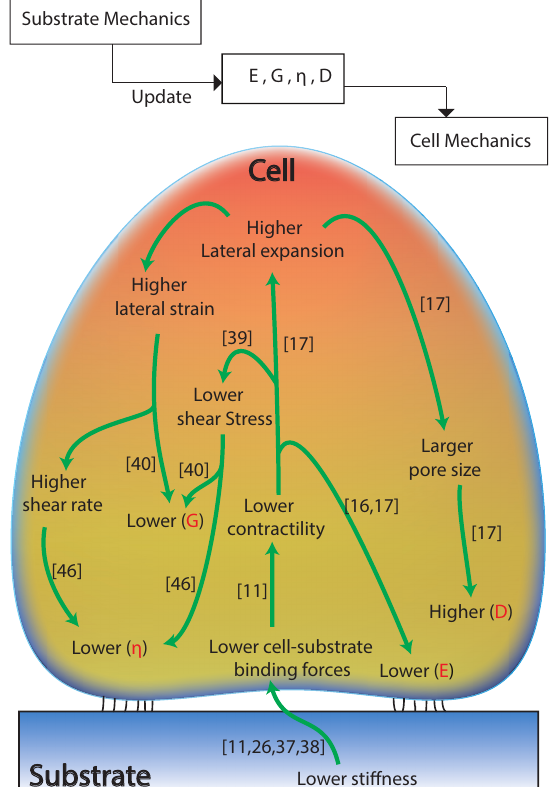
Figure 3. Schematic sketch of the cell biomechanical behavior change in response to substrate